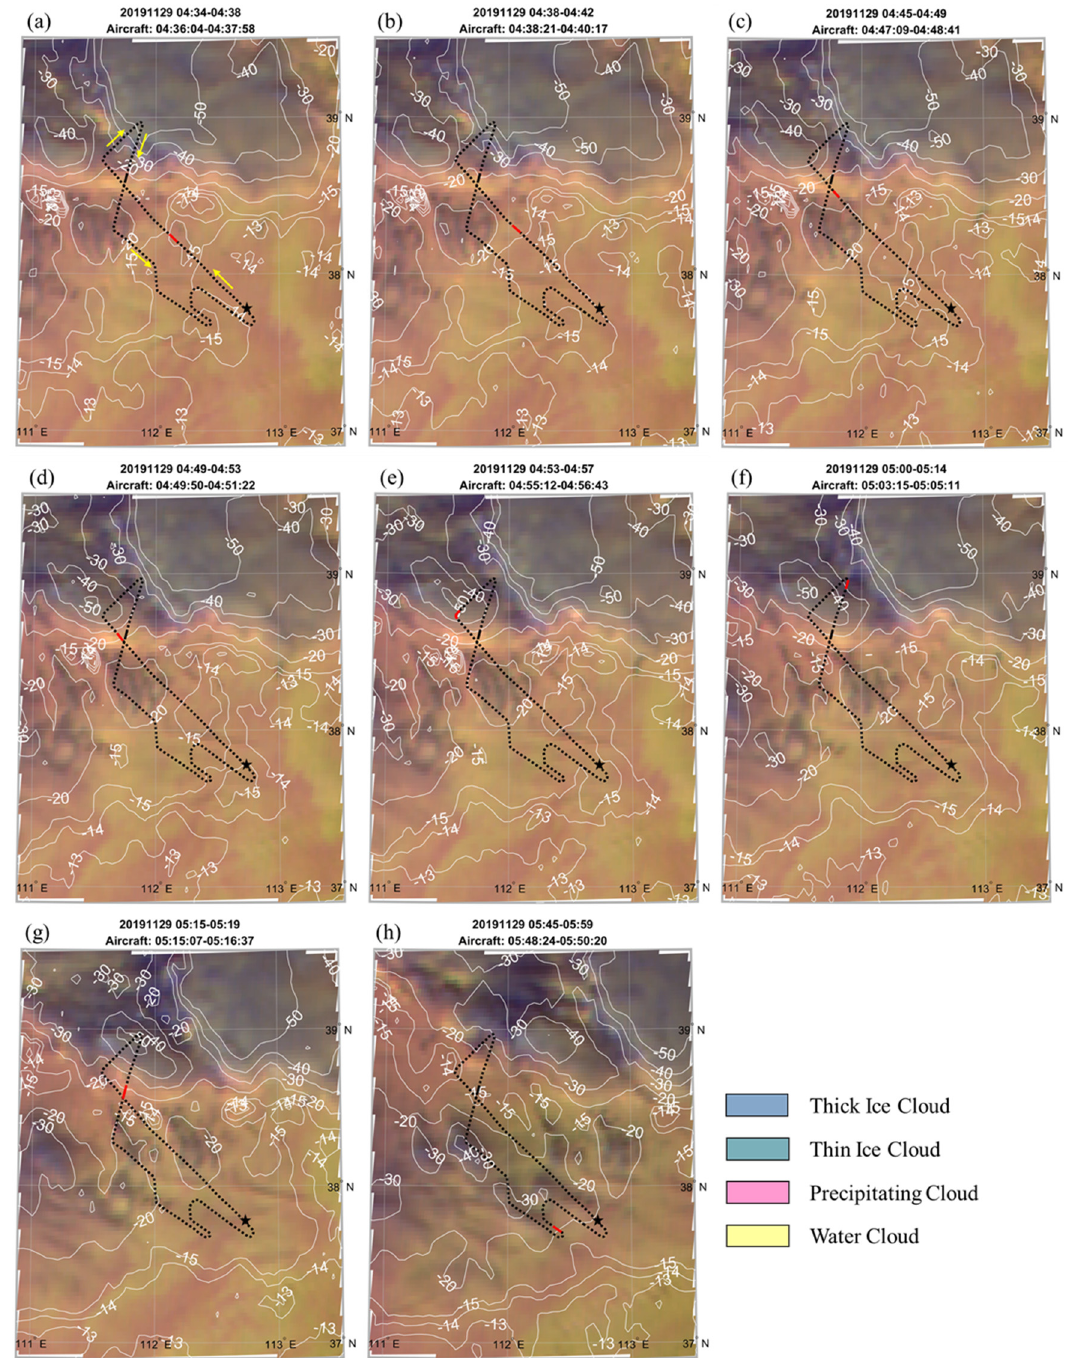
Figure 9. Multispectral composite image of FY-4A satellite at different scanning times and aircraft measuring times marked on the top of A to H on 29 November 2019. The black dashed line is the aircraft flight trajectory (03:53–06:05 UTC) with the yellow arrow marking the flight direction, and the asterisk indicates the location of the airport. The red solid line is the time of the cloud phase obtained from the satellite and aircraft measurements at the same time. The white solid line is an isoline of the cloud top brightness temperature (°C) at the 10.8 µm channel of the satellite. As seen in Figure 9a–g of the multispectral composition, from 04:30 to 05:19 UTC, the cloudy area north of 38.5°N is mainly blue tones, and the south is mainly red or yellow tones, indicating that the cloud area north of 38.5°N is mainly ice clouds, and the south is mainly water clouds. The cloud top brightness temperature is lower than 0 °C, indicating